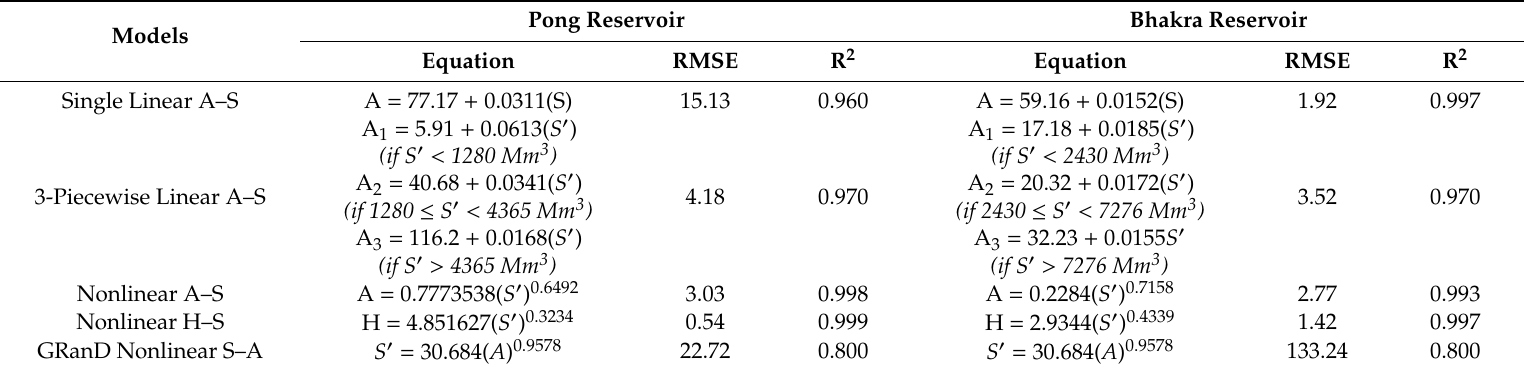
Table 2. Calibrated Pong and Bhakra H–A–S